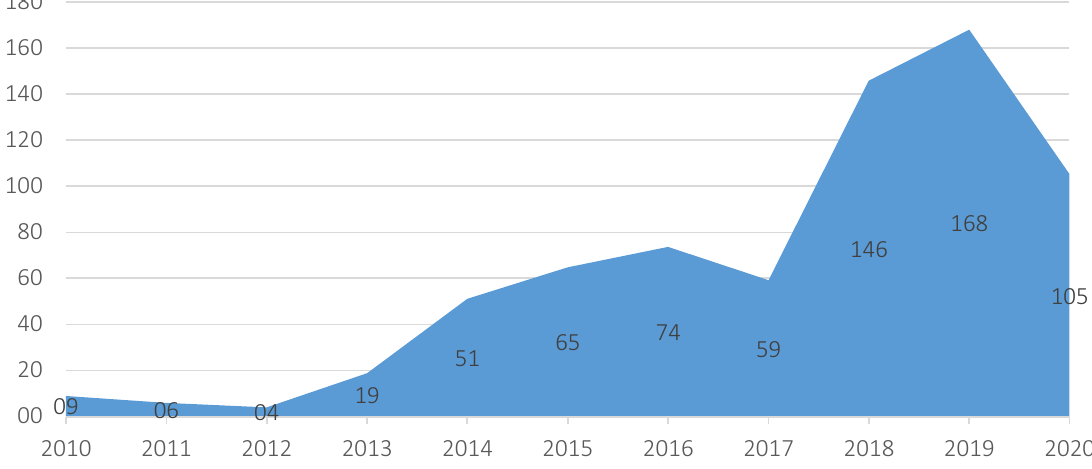
Figure 1. Total global investment in FinTech by year, billions of